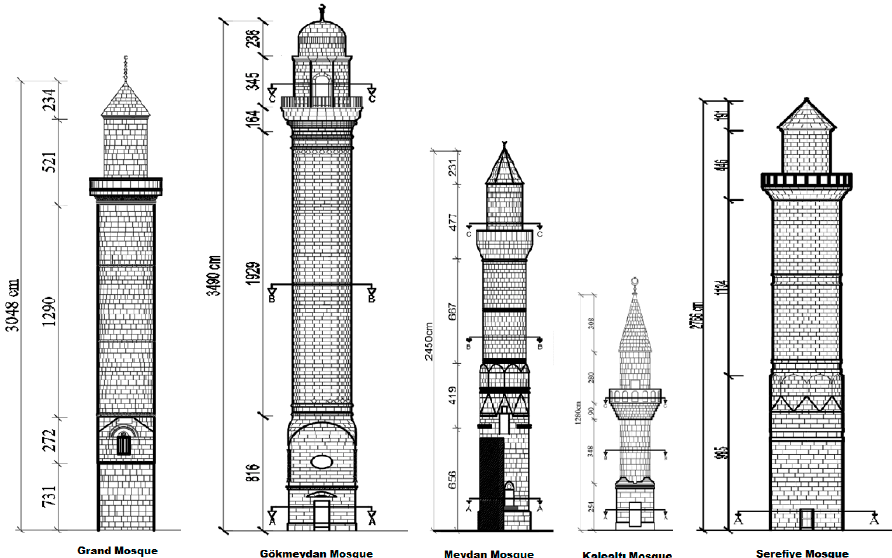
Table 3. The seismic parameters obtained for Five Minarets.